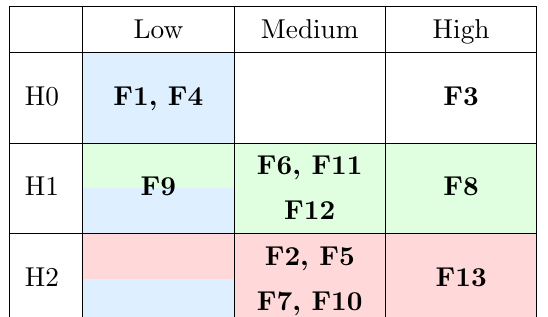
Table 4. Properties of the PGU scenarios in terms of the VL mass hierarchy and the uni(cid:12)cation scale and their susceptibility to various experimental search strategies. Light blue indicates the models that are tested by the proton decay measurements. Those highlighted in light green can be subject to color searches: R -hadrons and running of the strong gauge coupling. Light red corresponds to the scenarios tested through EW interaction in lepton-like HSCP searches and EW precision